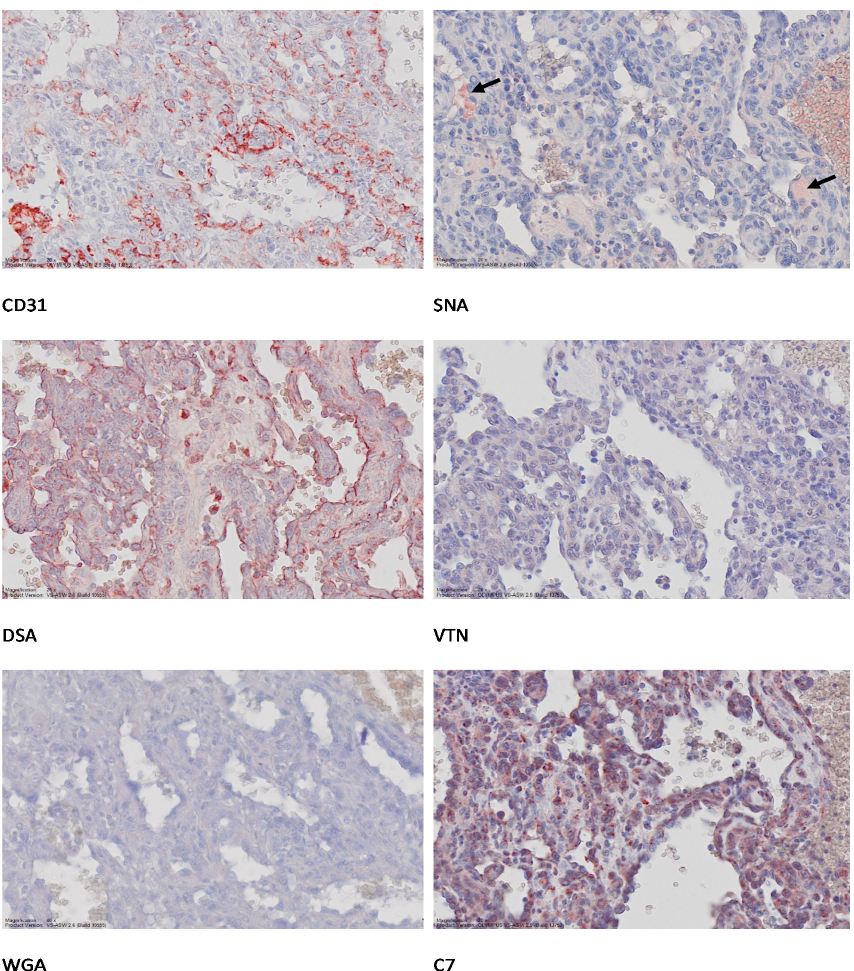
Figure 2. Lectin-histochemistry and immunohistochemical labelling of canine splenic HSA. Formalin-fixed paraffin-embedded (FFPE) sections were reacted with anti-human CD31 antibody, anti-human VTN antibody, anti-human complement C7 antibody, and biotinylated lectins DSA ( Datura stramonium ), WGA (Wheat Germ Agglutinin), and SNA ( Sambucus nigra ) lectins) on consecutive splenic HSA sections (sample 13_019400E). Binding was visualized using AEC substrate (red) following either incubation with secondary antibody (Envision Kit) or streptavidin-horse radish peroxidase conjugate. Microphotos were generated using Aperio scans. Original magnifications 20×.